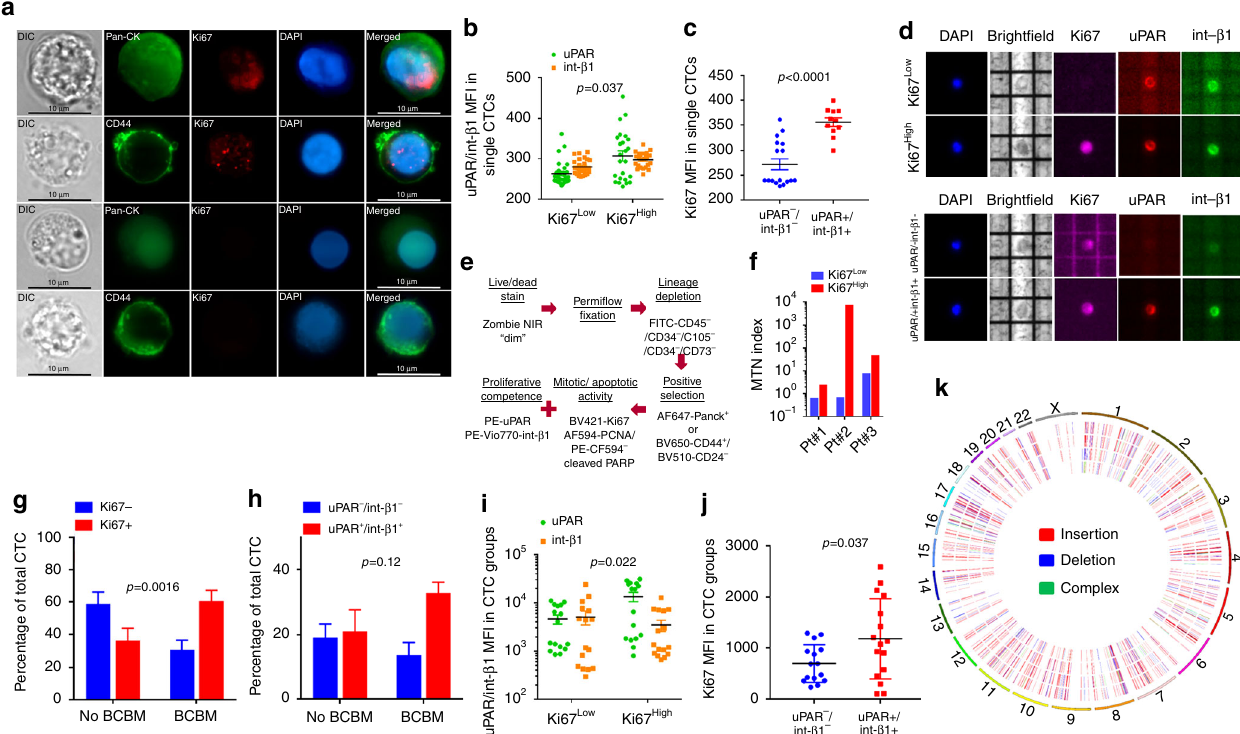
Figure 3 The assessment of proliferation-related biomarkers in breast cancer patient-derived CTCs. a Ki67 staining in PanCK+ and CD44+/CD24 − CTC subtypes isolated from breast cancer patient blood. Scale bar = 10 μ m. b uPAR and int- β 1 expression in single CTCs designated as Ki67 Low ( n = 60) or Ki67 High ( n = 48). p -value was calculated by two-way matched ANOVA. Despite a statistically signi fi cant overall difference, 20 – 30% individual CTCs in both groups had similar uPAR and int- β 1 expression. c Ki67 expression in single CTCs designated as uPAR − /int- β 1 − ( n = 17) or uPAR+/int- β 1+ ( n = 11). p -value calculated by unpaired t -test. Of note, 7 out of 17 uPAR/int- β 1 CTCs had higher Ki67 expression than the rest of the group. d Demonstration of Ki67, uPAR, and int- β 1 staining of single CTCs by DEPArray TM . Note that the CTC in the third row, is designated as uPAR − /int- β 1, but the Ki67 expression is higher than the Ki67 Low CTC shown in the fi rst row . e Flowchart depicting PBMC processing for concomitant cell surface and nuclear staining for single-step analysis by fl ow cytometry. PCNA was replaced by cleaved PARP (Asp214) in the last eight samples to accommodate an apoptosis marker in the nine-color panel . f MTN index of Ki67 Low vs. Ki67 High CTCs assessed by the Permi fl ow TM method. g Difference in Ki67 status of BCBM vs. no BCBM patient-derived CTCs ( n = 8). p- value calculated by two-way matched ANOVA test. h Difference in uPAR/int- β 1 expression status in BCBM vs. no BCBM patient-derived CTCs ( n = 8). p- value calculated by two-way matched ANOVA test. i uPAR and int- β 1 expression in CTC groups designated as Ki67 Low or Ki67 High ( n = 32). p -value calculated by two-way matched ANOVA. j Ki67 expression in CTC groups designated as uPAR − /int- β 1 − or uPAR+/int- β 1+ ( n = 16). p -value calculated by unpaired t -test. k Circos plot depicting cancer-related gene exon insertions/deletion (in/del) mutations in uPAR+/int- β 1+ and uPAR − /int- β 1 − CTC subsets obtained from BCBM and no BCBM patients. From outer to inner circle : uPAR+/int- β 1+ and uPAR − /int β 1 − CTCs derived from BCBM patient; uPAR+/int β 1+ and uPAR − /int- β 1 − CTCs derived from no BCBM patient. 881/884 in/del mutations found in BCBM subsets, whereas 434/211 in/del in no BCBM subsets. Error bars represent